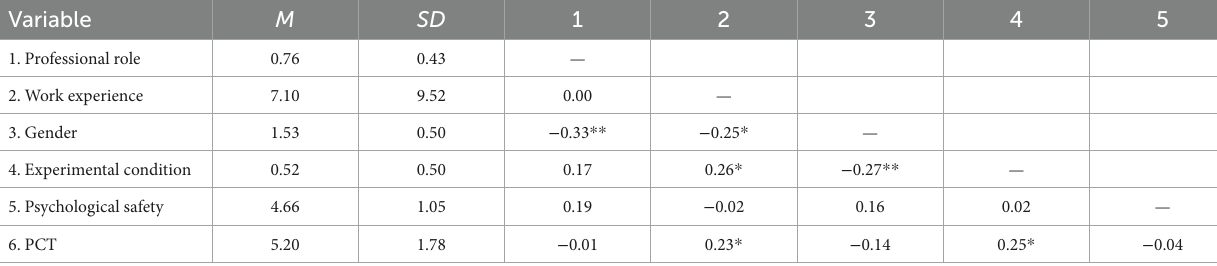
TABLE 1 Descriptive statistics and correlations. Variable